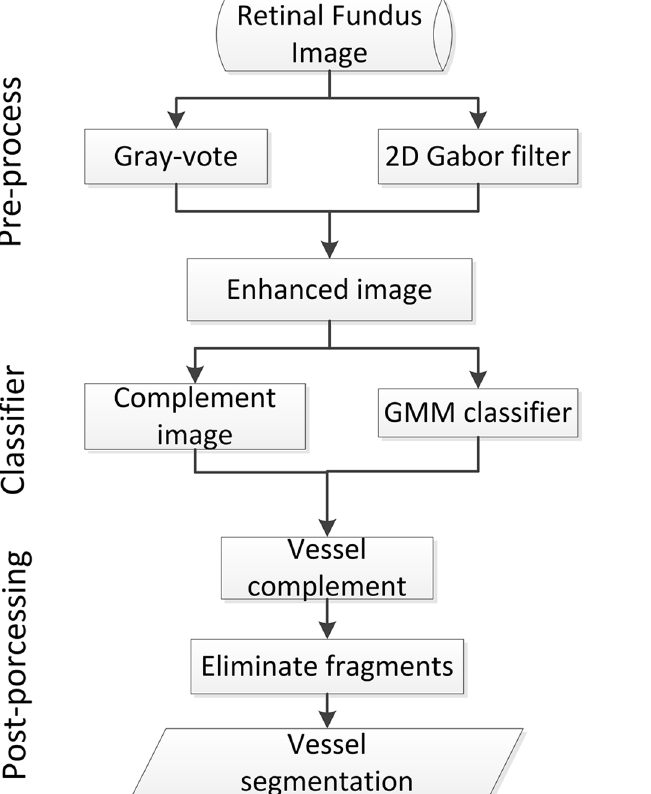
Fig 1. Block diagram of the proposed